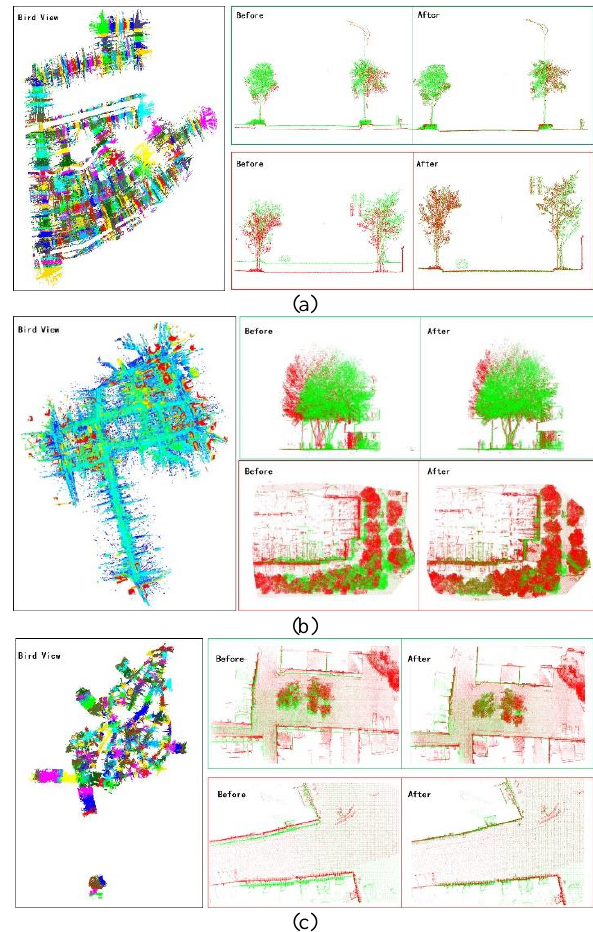
Figure 8. Position correction result of MLS point clouds in: (a) Shanghai, China (b) Wuhan, China, (b) Tallinn,